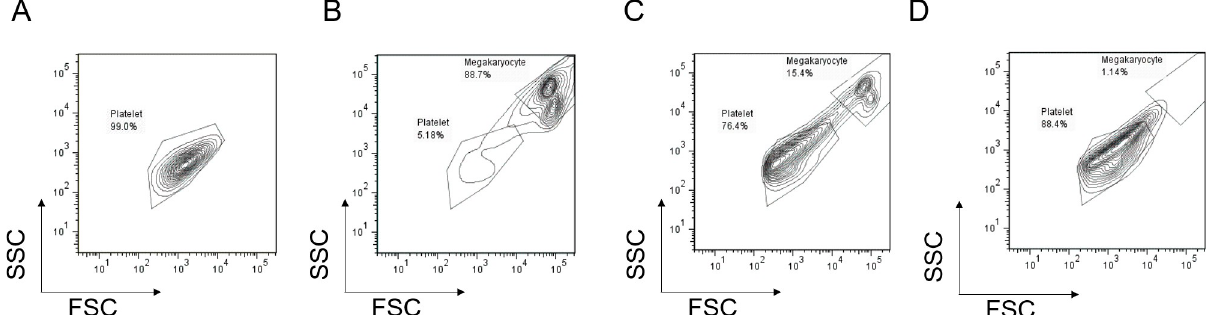
Fig 3. Flowcytometric profile of cells. (A) Platelets of healthy volunteer donor. (B) Megakaryocytes prior to platelet-like cells production. (C) Platelet- like cells produced by in vitro production system. (D) Platelet-like cells produced by ex vivo production system.